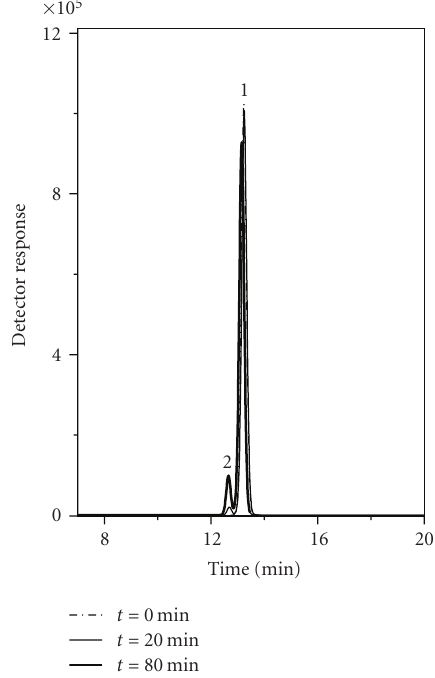
Figure 6: HPLC chromatograms obtained from samples of degra- dation of paracetamol collected at di ff erent